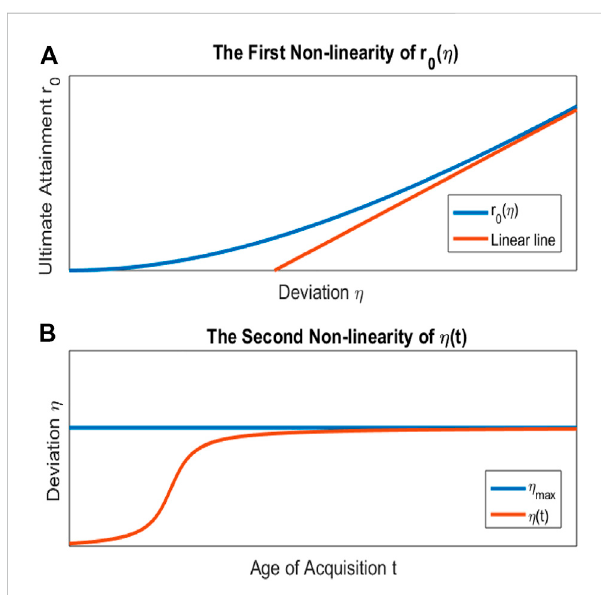
FIGURE 4 Doublenon-linearityof r 0 ( η ) [ (A) : fi rstnon-linearity]and η ( t ) [ (B) : second non-linearity] at early